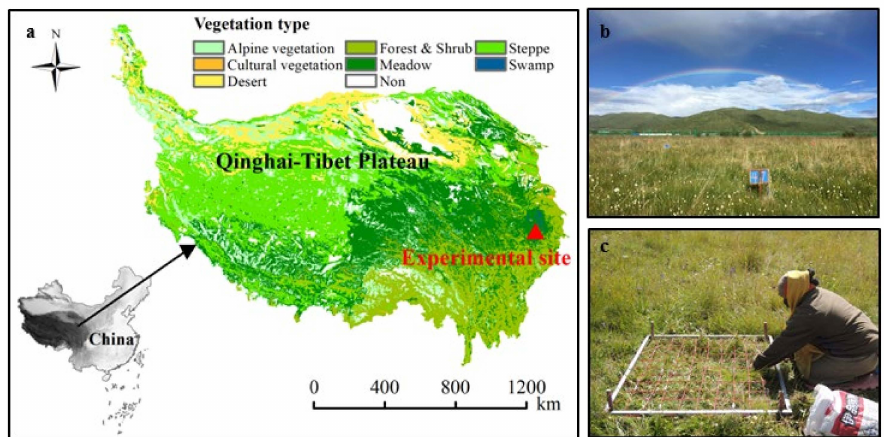
Figure 1. Location ( a ), sample plot ( b ) and vegetation investigation ( c ) of study area in Qinghai- Tibetan Plateau.